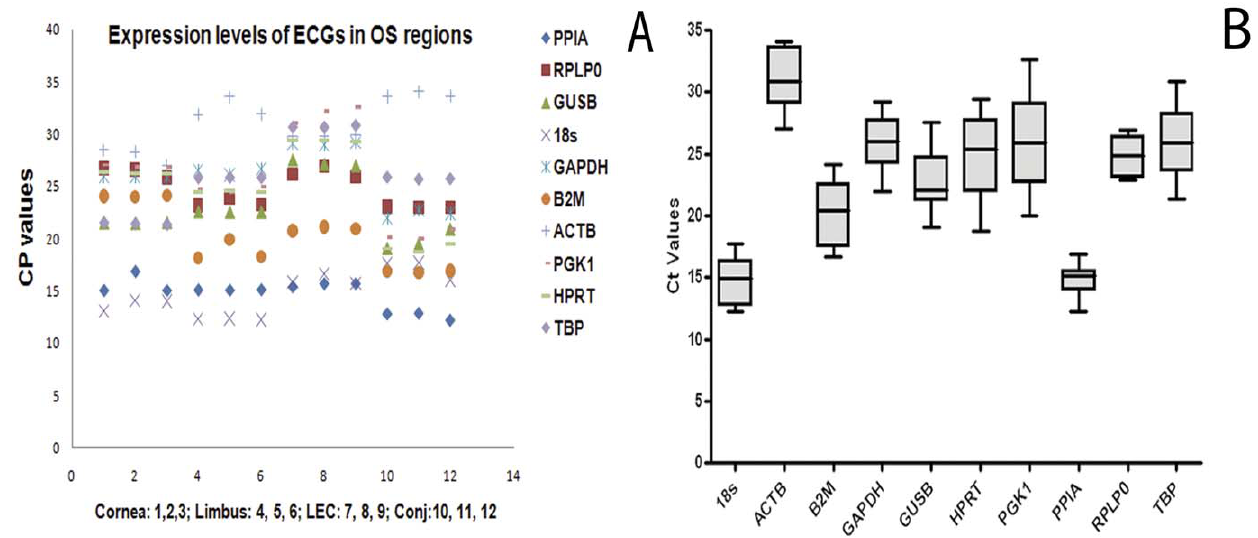
Figure 1. Distribution of cp values of ECGs in different OS epithelial regions. Figure 1A, the scatter graph of the Cp values of all the ECGs shows all the ECGs had cp value # 35. The order of samples 1–12 were as follows: Samples 1, 2, 3 were cornea 1, cornea 2, cornea 3, samples 4, 5, 6 were limbus 1, limbus 2, limbus 3, samples 7, 8, 9 were LEC 1, LEC 2, LEC 3 and samples 10, 11, 12 were conjunctiva 1, conjunctiva 2, conjunctiva 3. Figure 1B is a box plot of q PCR cp values of the ECGs. Each box plot is mean Cp value of all OS epithelial regions. The median Cp value is represented as black line within the box plot, and it divides the Cp values into lower and upper quartile ranges. The whiskers represent the upper and lower data range for the samples tested. The box plot of PPIA demonstrates tight distribution of the samples around the median value. Similarly box plot of RPLP0 shows uniform distribution of Cp values around the median with tight whisker distribution.